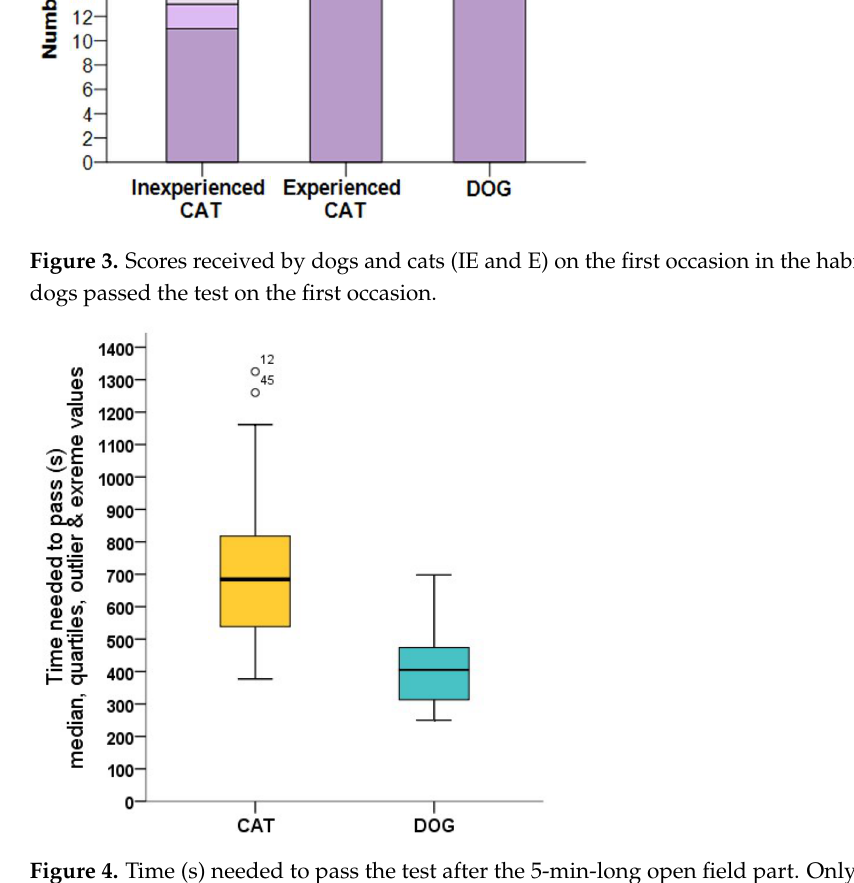
Figure 4. Time (s) needed to pass the test after the 5-min-long open field part. Only data of the cats successfully habituated on the first occasion were analysed.